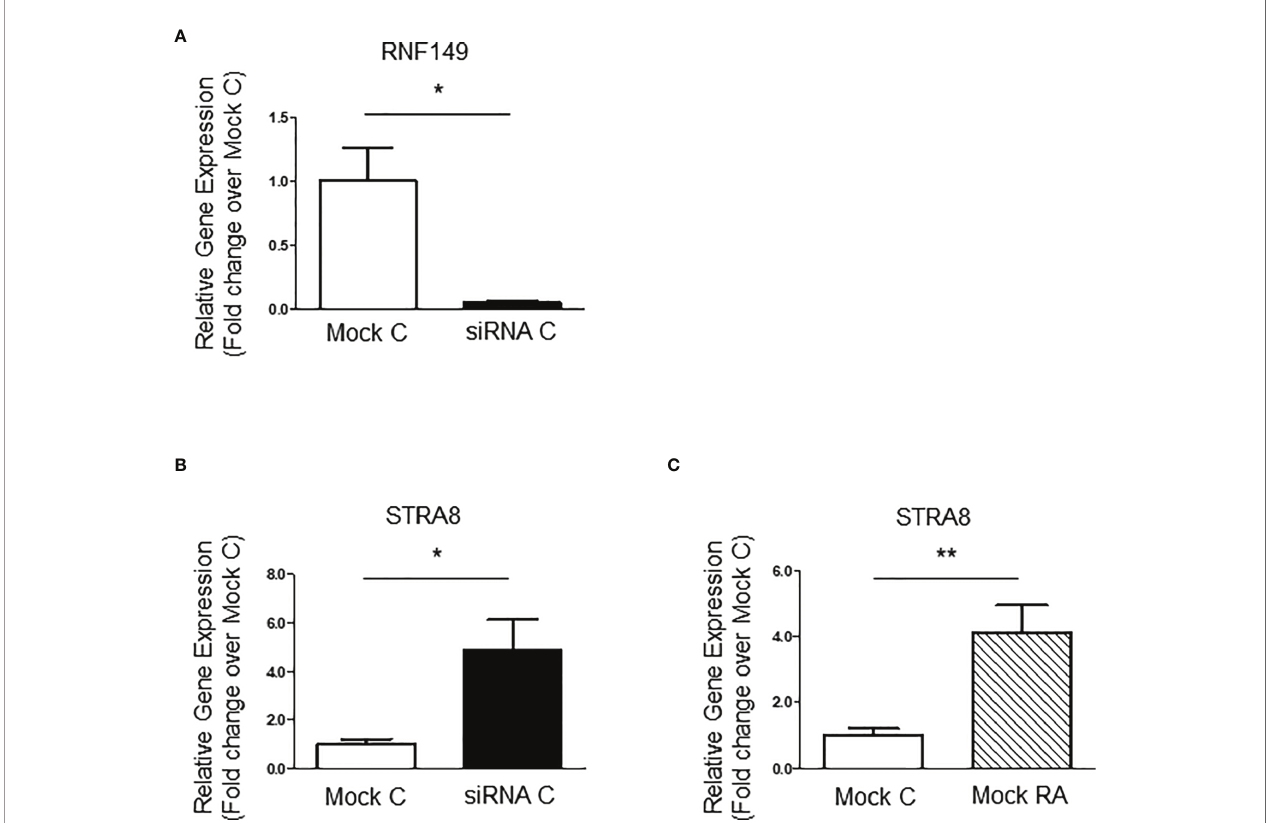
FIGURE 3 | RNF149 knockdown in C18-4 cells. (A) RNF149 mRNA expression in C18-4 cells treated with mock and siRNA for 48 hours. Results shown are from N=3 independent cell passages and are plotted mean ± SEM. *p-value<0.05. (B) Stra8 mRNA expression in C18-4 cells treated with mock and siRNA for 48 hours. *p-value<0.05. (C) Stra8 mRNA expression in mock cells treated with or without RA (10 -7 M) for an additional 24 hours.